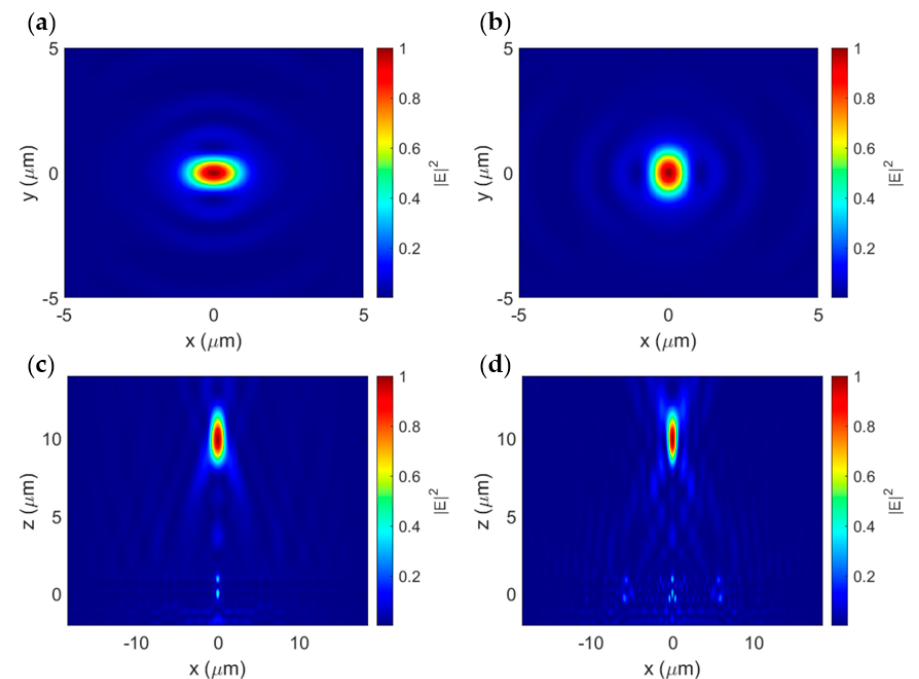
Figure 7. Normalized electric field intensity distribution of ( a ) focal plane for x -polarized light, ( b ) focal plane for y -polarized light, ( c ) propagation cross-section along focal spot major axis, and ( d ) propagation cross-section along focal spot minor axis.